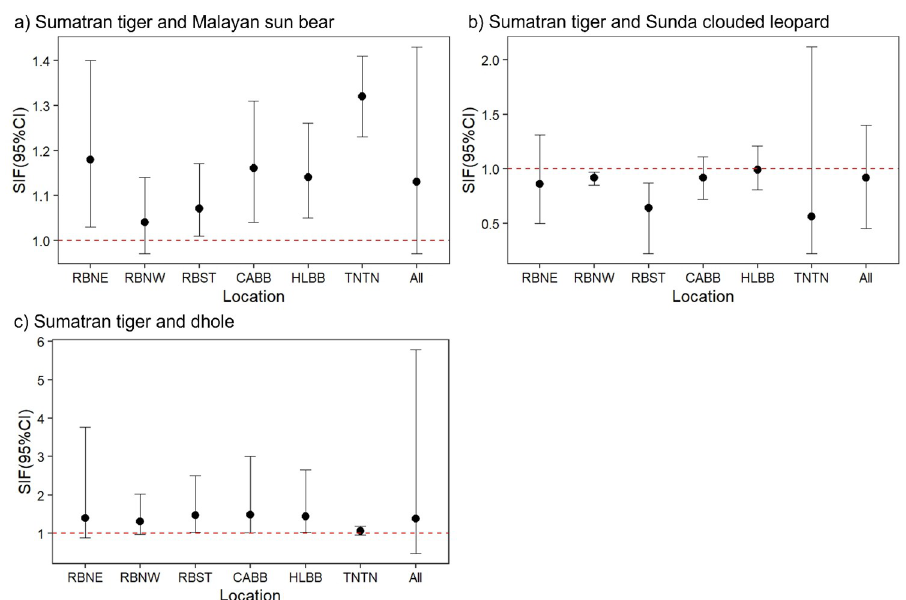
Fig 5. Spatial overlap between Sumatran tigers (dominant, species A) and other large carnivores (subordinate, species B) based on model-averaged Δ AICc � 2 for 147 camera-trap stations across all study sites. A strong SIF is indicated by the 95% CI not overlapping with “1”; RBNE, Northeastern Bukit Rimbang Bukit Baling; RBNW, Northwestern Bukit Rimbang Bukit Baling; RBST, Southern Bukit Rimbang Bukit Baling; CABB, Bukit Bungkuk; HLBB, Bukit Betabuh; TNTN, Tesso Nilo; All, “All study sites”.